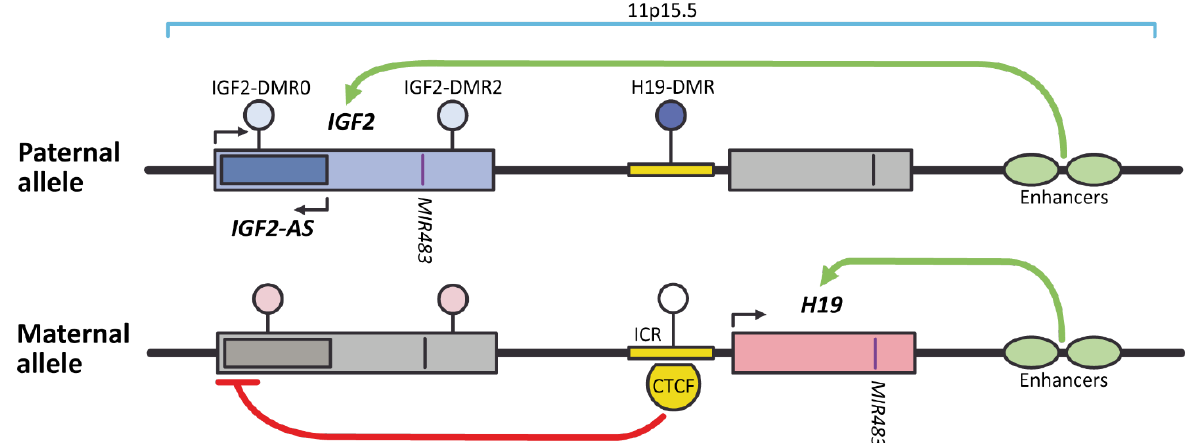
Figure 2. The schematic representation of IGF2-H19 imprinted locus (based on genome assembly GRCh38.p12). On the paternal allele, methylation of H19-DMR directly blocks the promoter of H19 gene, but does not prevent 3′ enhancers from activating transcription of IGF2 , IGF2-AS , and MIR483 genes. On the maternal unmethylated allele, transcriptional repressor CTCF can bind to the ICR overlapping with H19-DMR and block IGF2 promoter. The enhancer can still efficiently activate the unmethylated H19 promoter and induce expression of both H19 and located in it MIR483 . Dark ellipse represents fully methylated “primary” H19-DMR, open ellipse represent unmethylated “primary” DMR; light colored ellipses are for “secondary” somatic IGF2-DMR0 and IGF2-DMR2, differentially methylated on paternal and maternal chromosomes only in several tissues. Gray boxes and black strokes indicate non-expressing genes. Transcriptionally-active genes are marked with colored boxes and purple strokes.